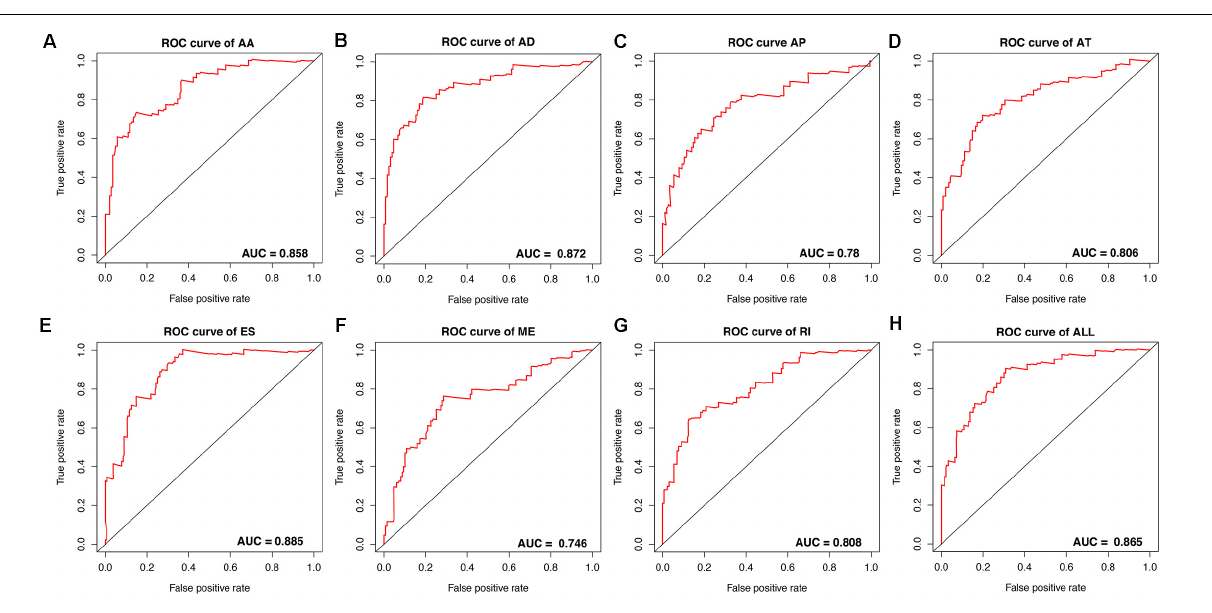
FIGURE 6 | ROC curves with calculated AUC values of prognostic predictors constructed with either one type or all seven AS types in the ESCA cohort. (A) AA: alternate acceptor site. (B) AD: alternate donor site. (C) AP: alternate promoter. (D) AT: alternate terminator. (E) ES: exon skip. (F) ME: mutually exclusive exons. (G) RI: retained intron. (H) ALL: all seven AS types